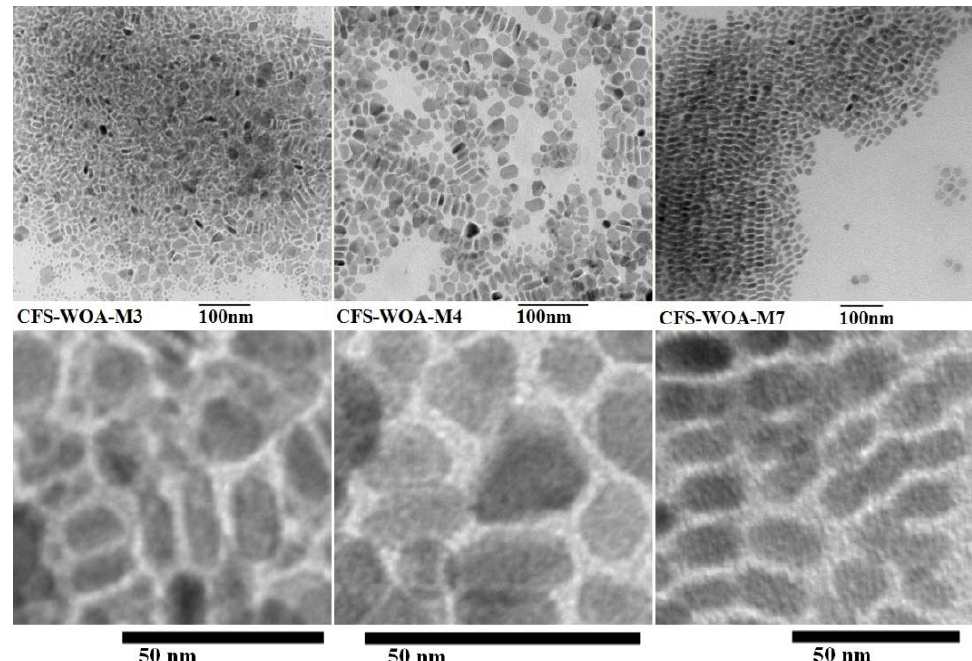
Fig. 3. Effect of different temperatures on the morphology of synthesized